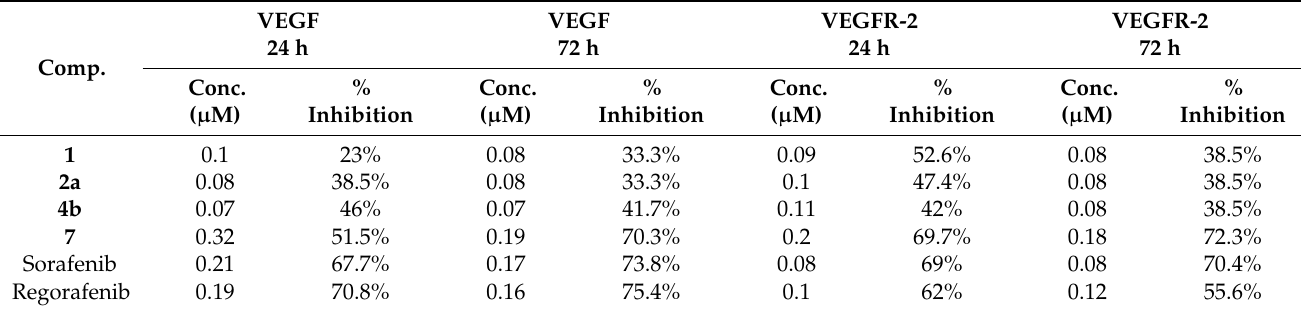
Table 3. Drugs and references lead compound effects in the HepG2 cell line compared to the control using ELISA as the percentage of